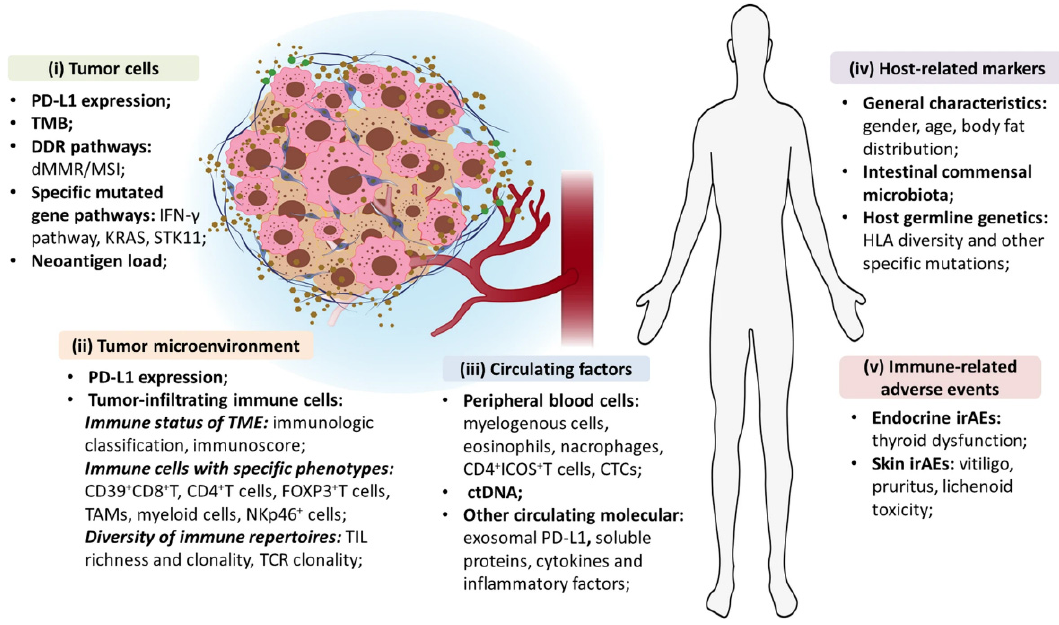
Figure 3. Exhaustive overview of biological biomarkers for the prediction of ICIs’ efficacy in NSCLC patients. Reproduced with permission from [151].